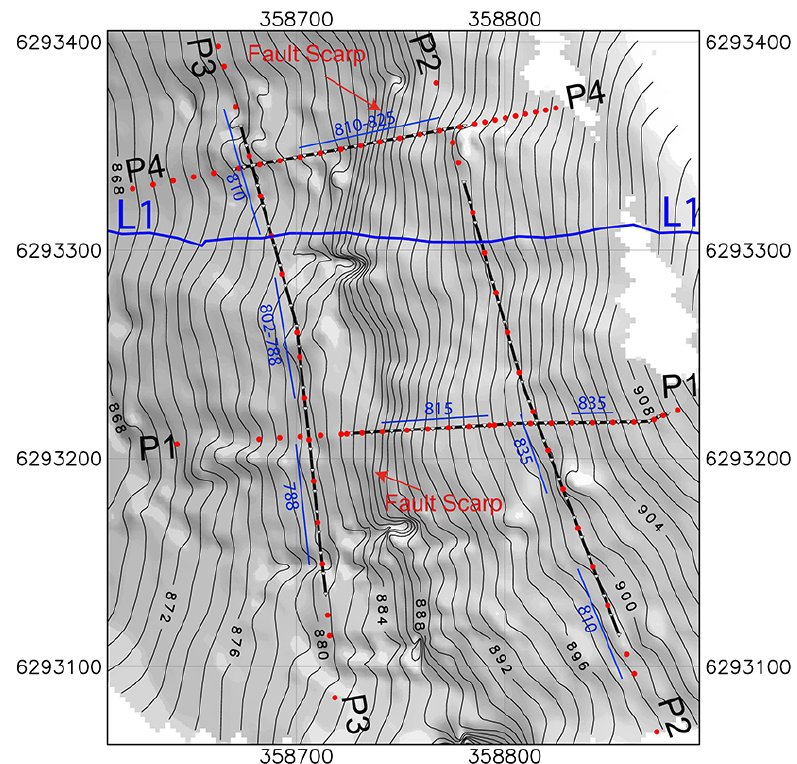
Figure A2. Estimated substratum depth [m]. Blue lines along seismic profiles P1–P4 mark the substratum depth, based on the 2-D seismic velocities